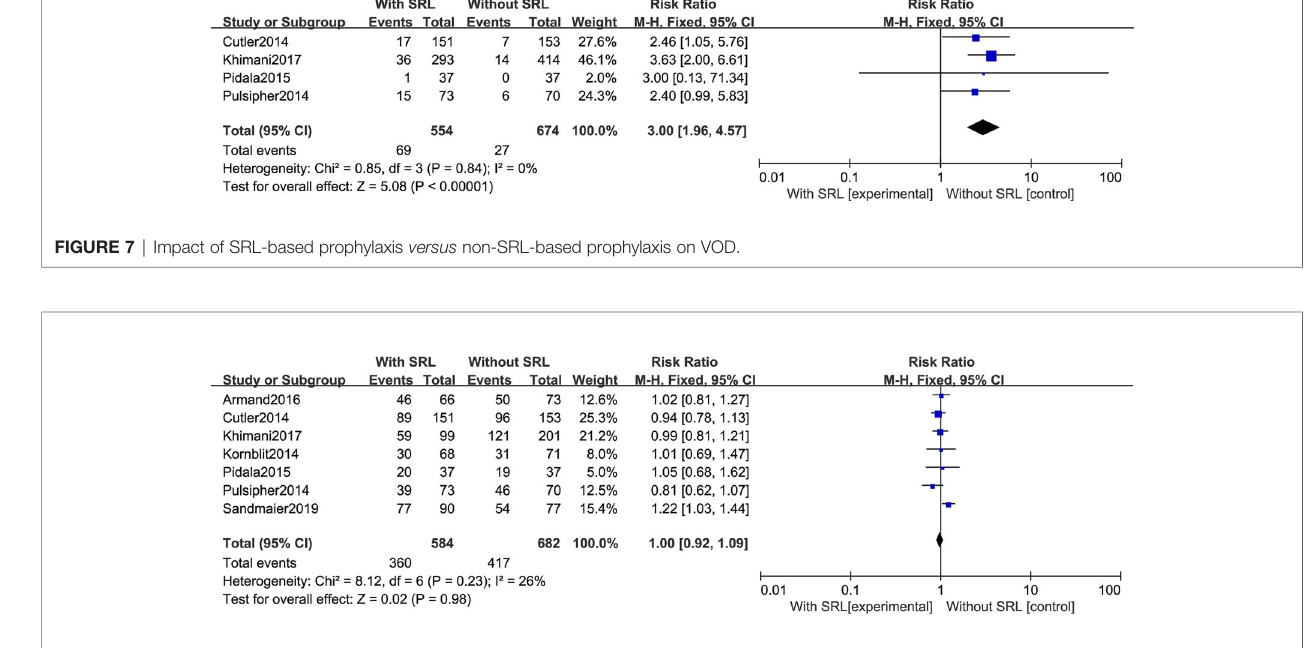
FIGURE 8 | Impact of SRL-based prophylaxis versus non-SRL-based prophylaxis on OS.